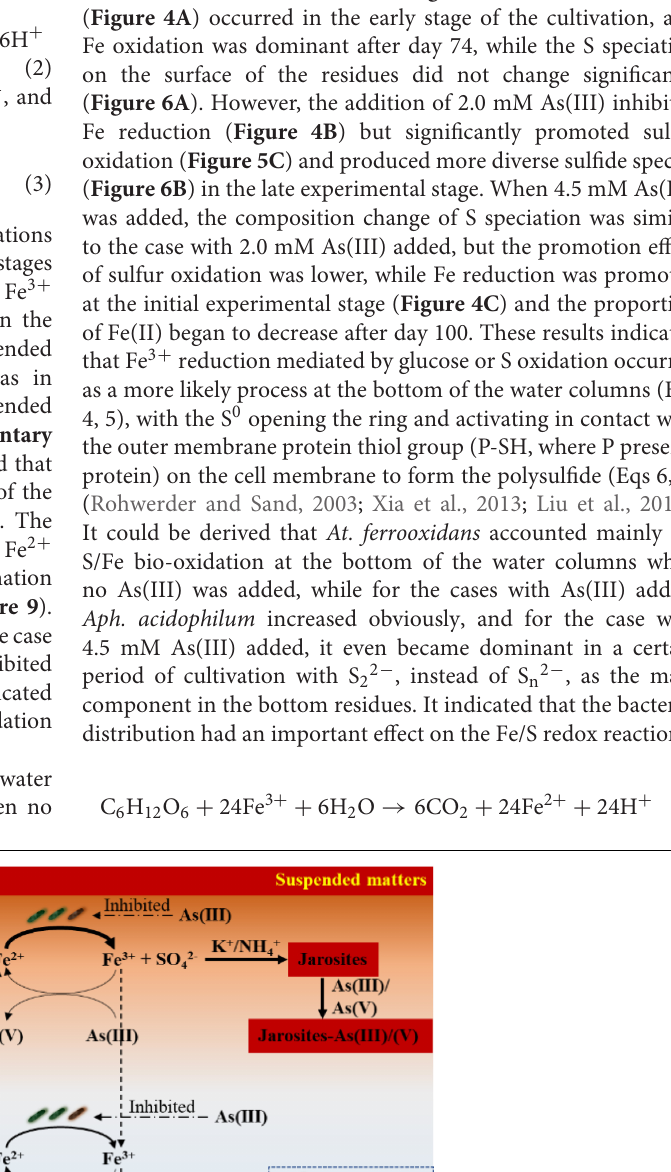
Frontiers in Microbiology |